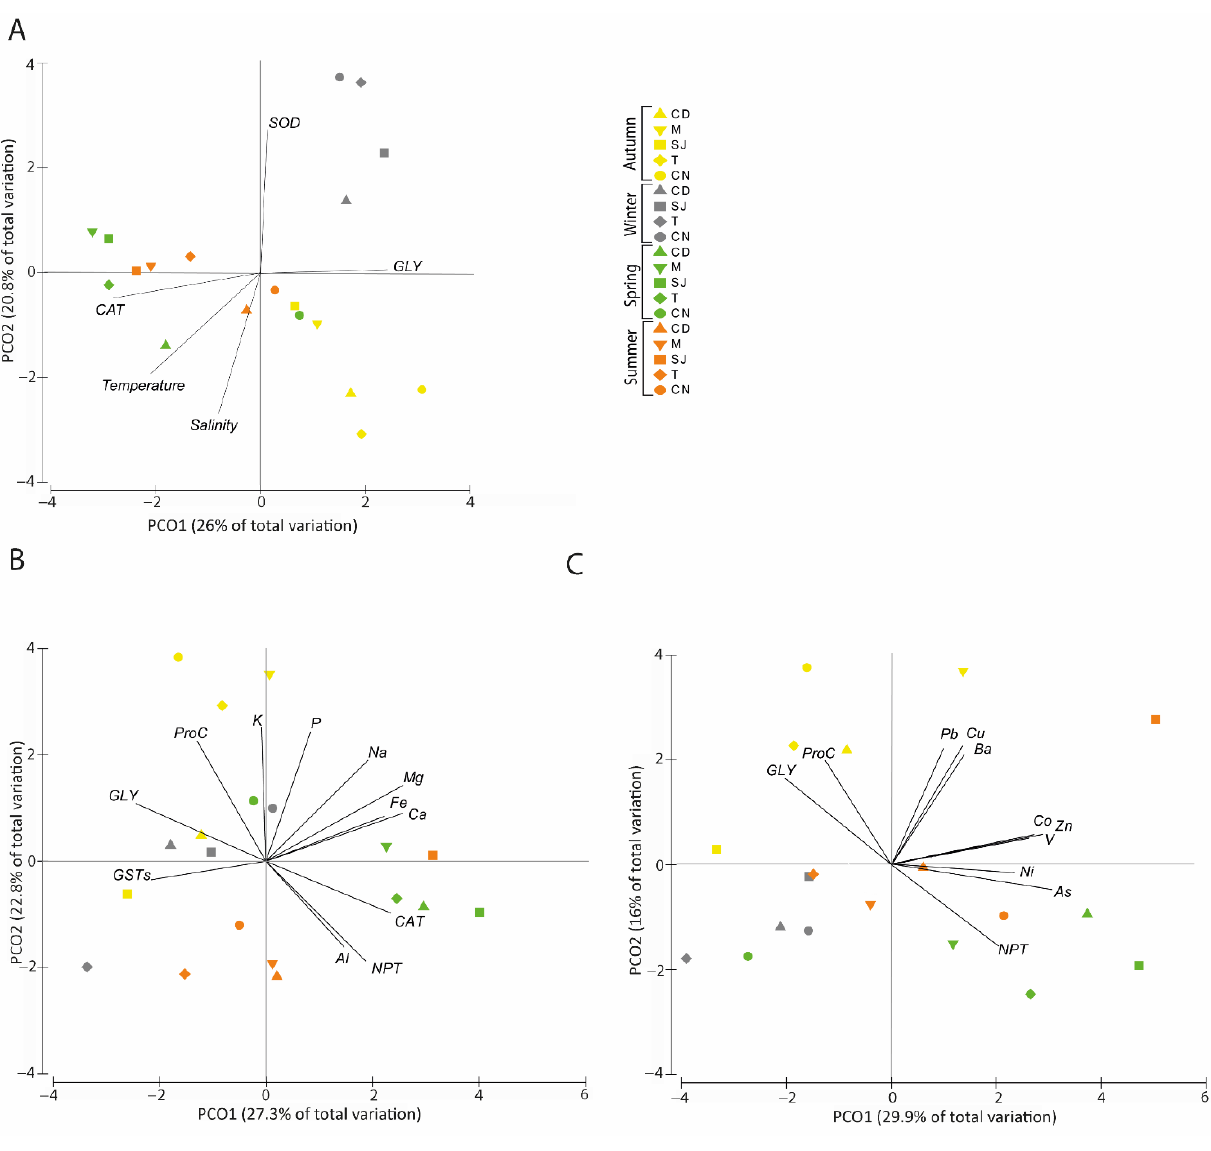
Figure 8. Principal coordinates ordination analysis (PCO) of ( A ) biochemical and physical–chemical parameters, ( B ) soluble fraction of Diopatra neapolitana tissues and biochemical parameters, and ( C ) soluble fraction of Diopatra neapolitana tissues and biochemical parameters. (r > 0.7). CD, M, SJ, T, and CN represent the sites Cale do Ouro, Murtosa, S ã o Jacinto, Torreira, and Costa Nova, respectively. A, W, Sp, and Su represent the seasons of the year: autumn, winter, spring, and